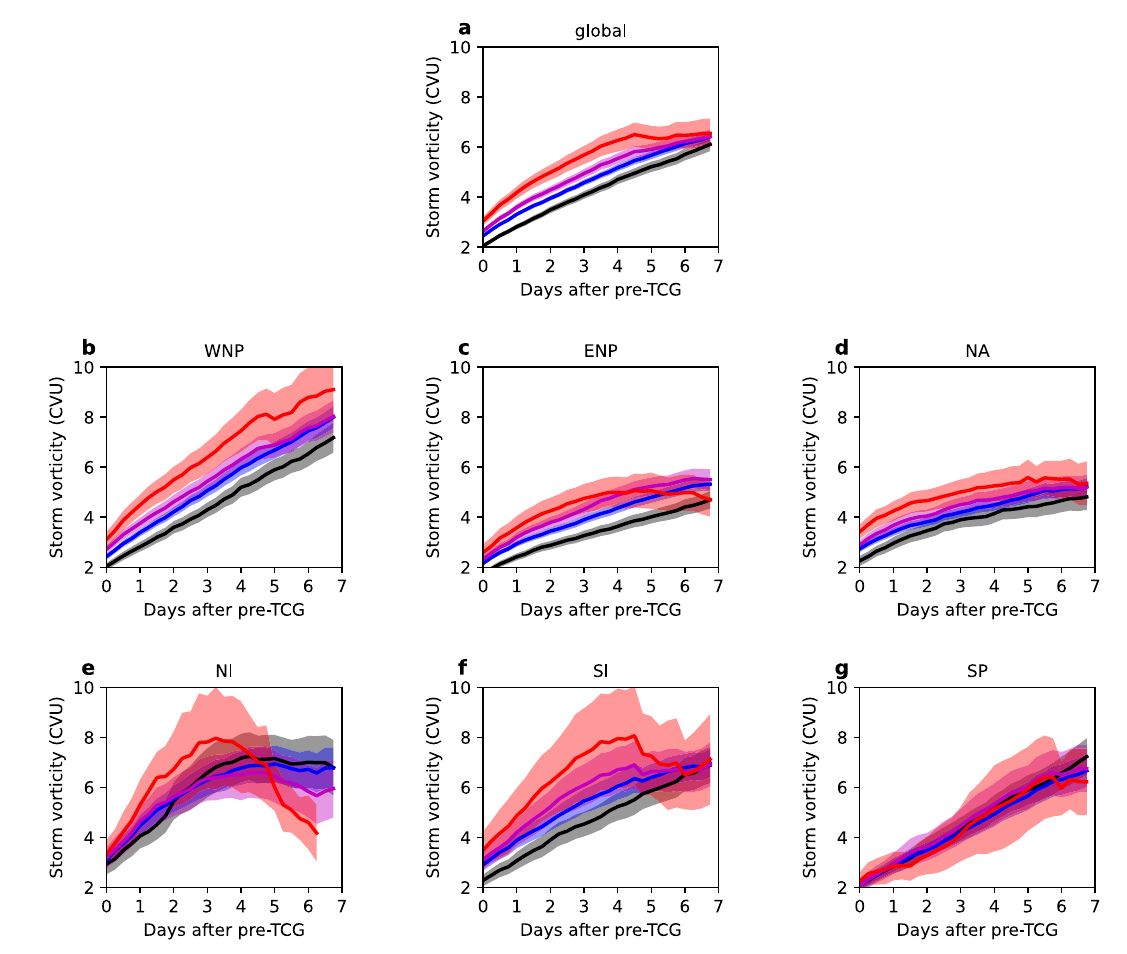
Fig. 5| Globaland basin-widepre-tropicalcyclone(pre-TC) intensity relatedto equatorial waves. a Global pre-TC intensity conditional on the phase matching in pre-tropical cyclogenesis (pre-TCG) events and equatorial waves, as a function of thetimeafterpre-TCGevents.Thephase-matchingincludes:notmatchedin-phase toanytypeofwestward-movingwaves(blackline),matchedinphasetoatleastone type(blueline),matchedin-phasetoatleasttwotypes(magentaline),andmatched in-phasetoallthreetypesofwestward-movingwaves(redline).Theshadingshows the95%con fi denceintervalofthemean.Pre-TCintensityisde fi nedbytheabsolute